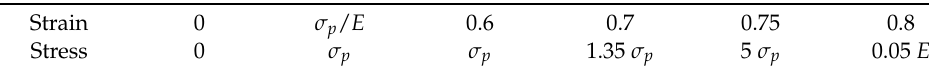
Table 1. Simplified stress–strain relationship of aluminum foam. Strain 0 σ p / E 0.6 0.7 0.75 0.8 Stress 0 σ p σ p 1.35 σ p 5 σ p 0.05